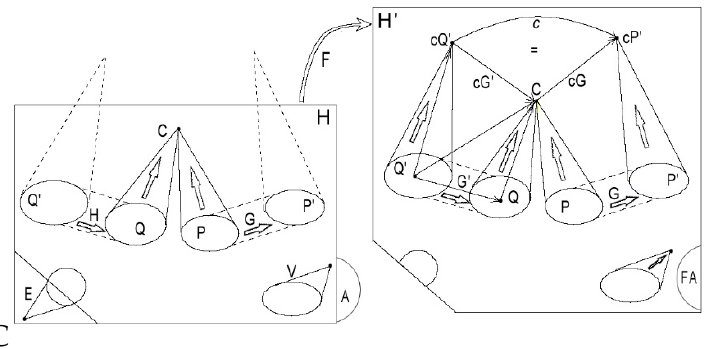
Figure 4. Construction of the complexification H' of H for the procedure Pr = (A, E, U).